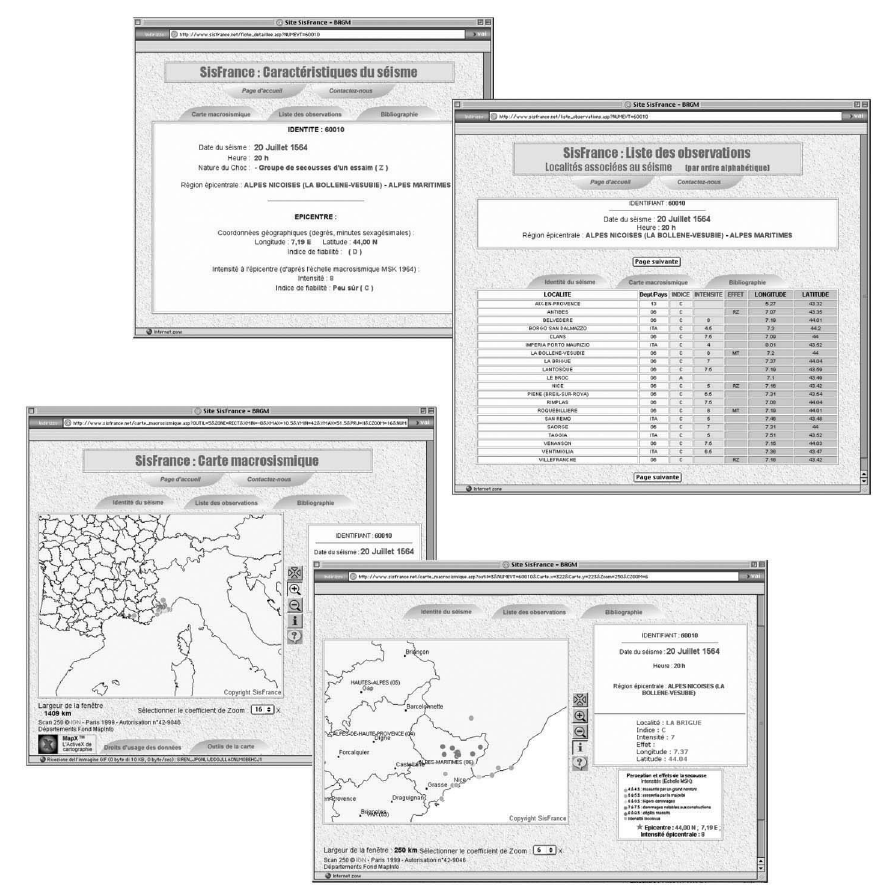
Fig. 3. SISFRANCE query by earthquake: main parameters of the event, IDP list and macroseismic